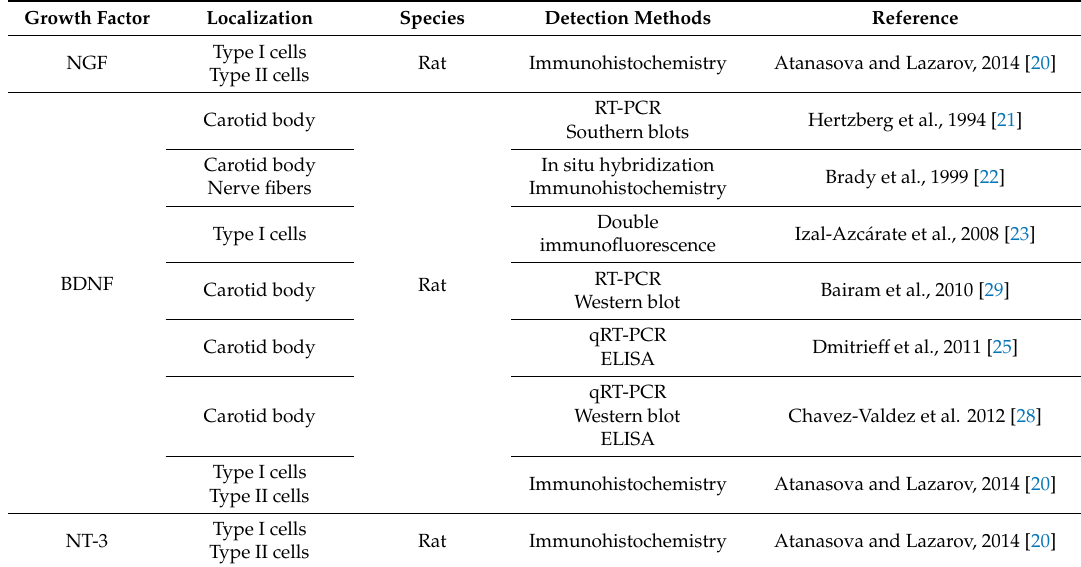
Table 1. Nerve growth factor family. Expression of NGF, BDNF, and NT-3 in the carotid body. Growth